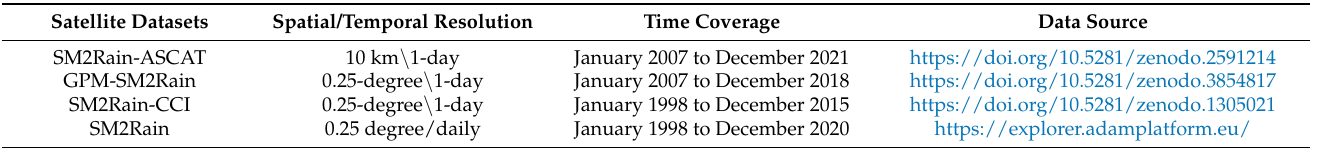
Table 1. Salient features of soil-moisture based satellite precipitation